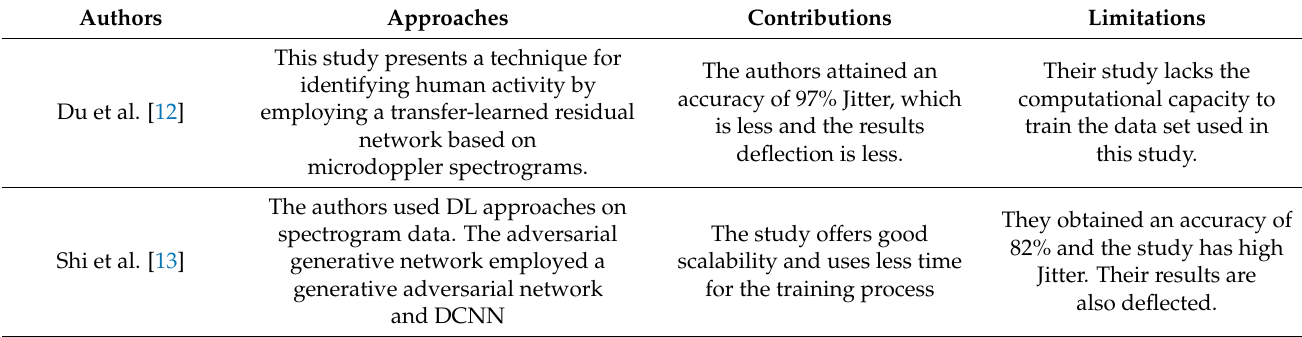
Table 1. Summary of HPC pieces of